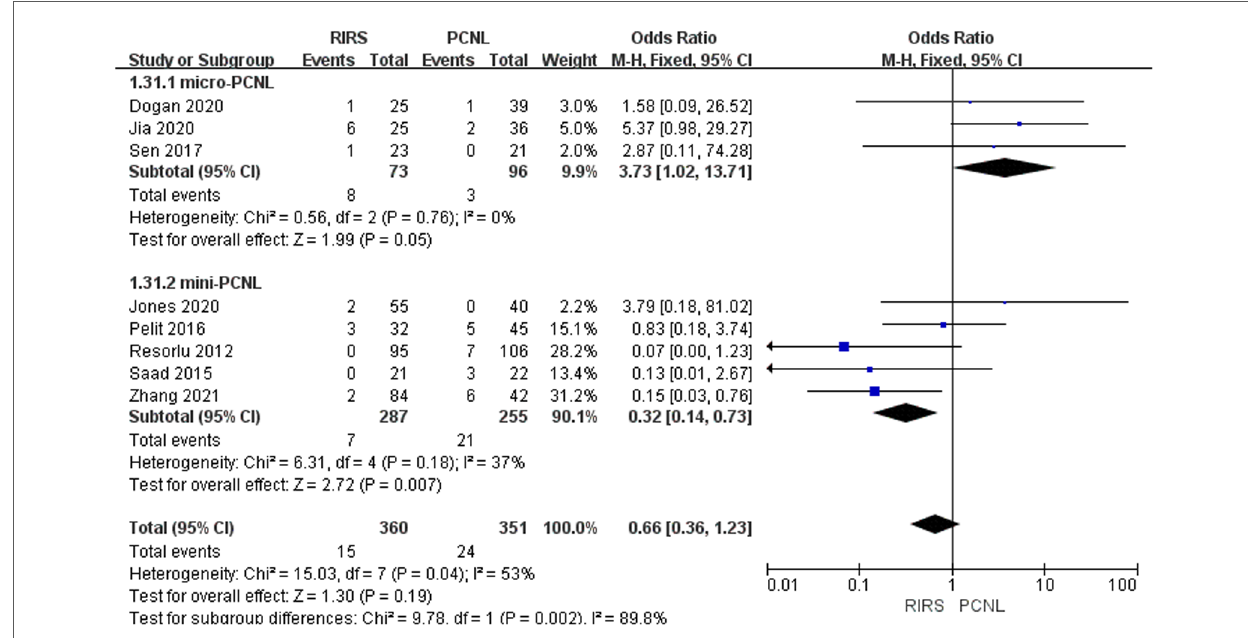
FIGURE 10 Forest plot of Clavien – Dindo grade II complication rate analysis between RIRS group and PCNL